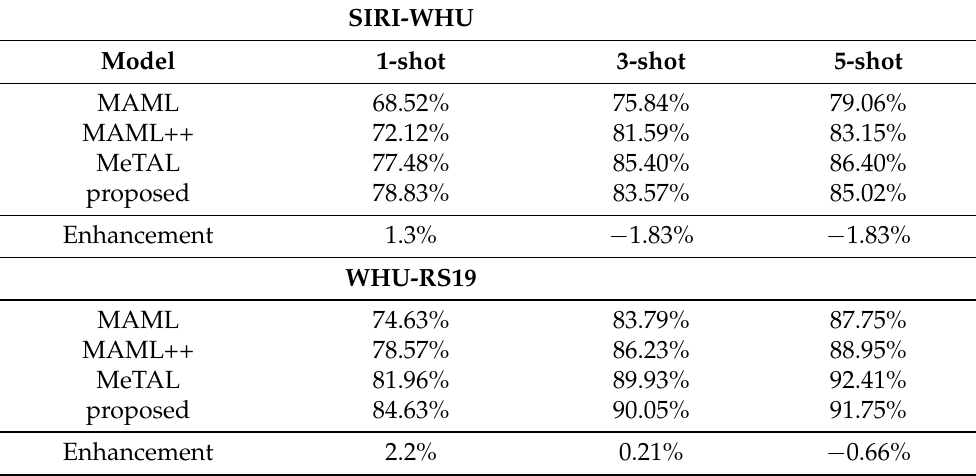
Table 6. Comparison of classification accuracy on SIRI-WHU and WHU-RS19